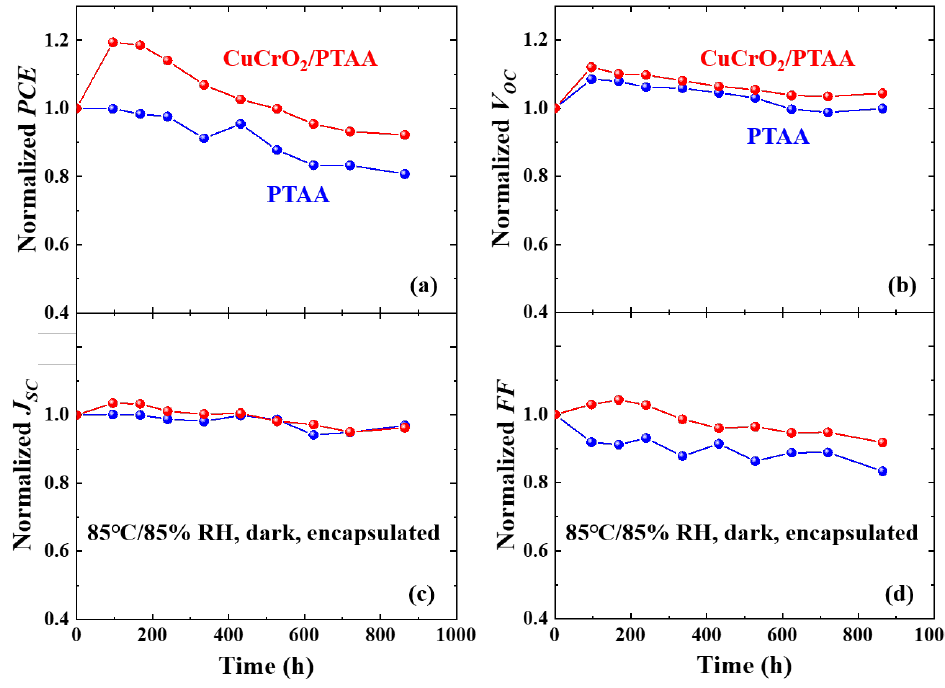
Figure 5. Thermal stabilities of solar cells with CuCrO 2 /PTAA or PTAA HTL: Normalized values of ( a ) efficiency, ( b ) V OC , ( c ) J SC , and ( d ) FF of the encapsulated solar cells stored under 85 °C/85% relative humidity (RH) dark condition.